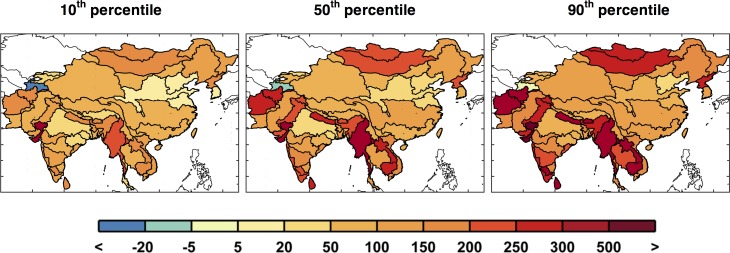
Changes from baseline in domestic water requirement (%) calculated point-wise by ASR, changes are based on the baseline (Fig 16) to the future scenarios averaged over 2041–2050 and shown for the 10th, 50th, and 90th percentiles for each ASR.